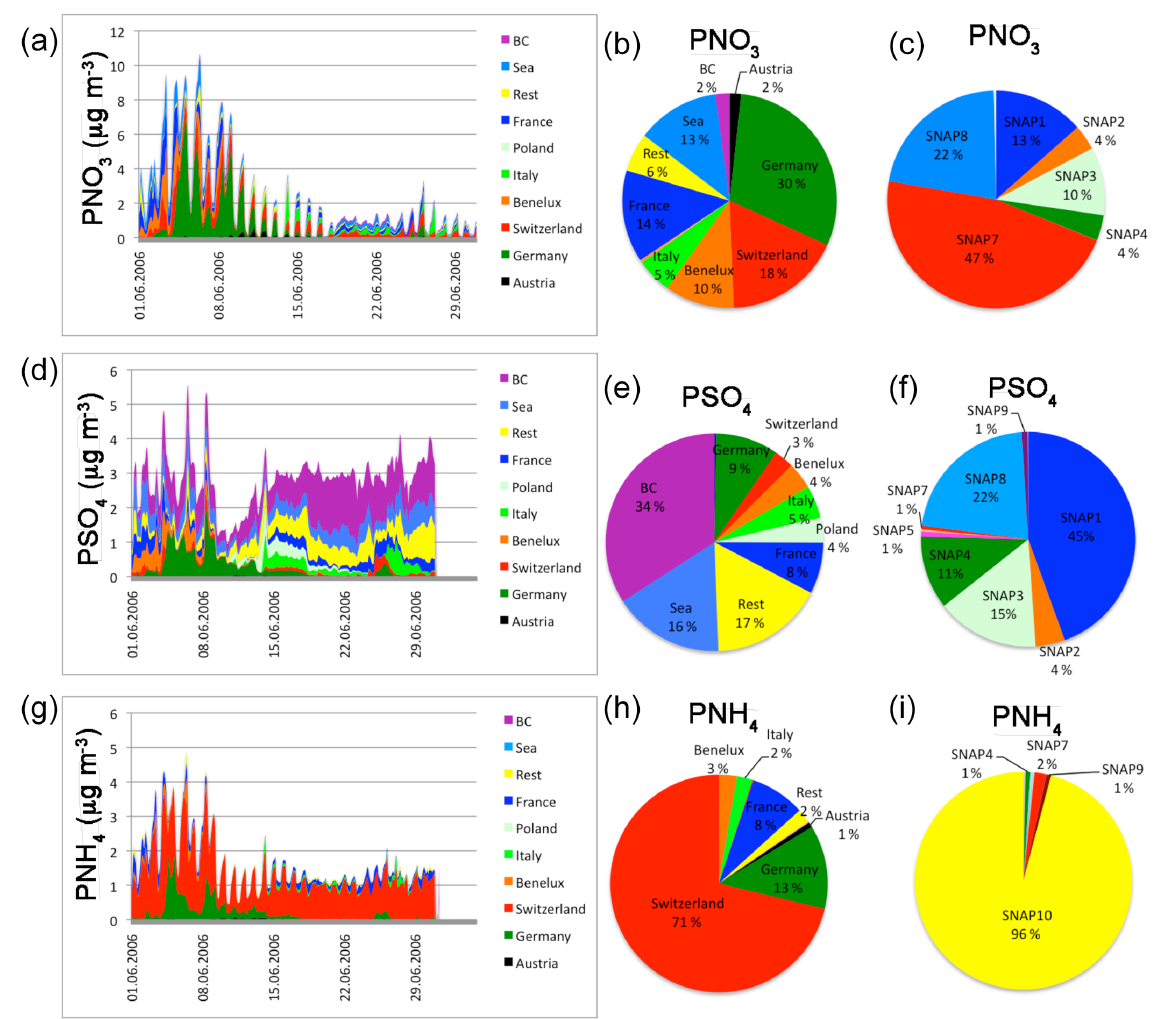
Figure 10. Contributions from various source regions (time series on a, d, g , pie-charts in b, e, h ) and categories (pie-charts on c, f, i ) to concentrations of PNO 3 (a–c) , PSO 4 (d–f) and PNH 4 (g–i) in the Swiss Plateau during June 2006. BC: boundary